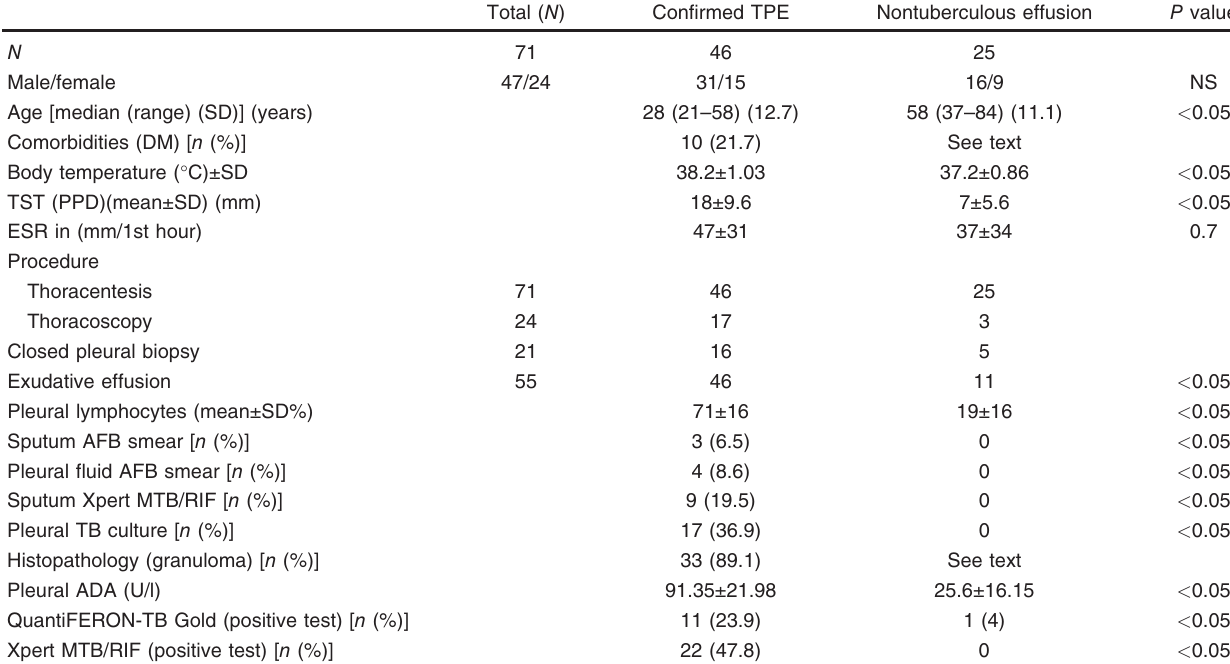
Table 1 The demographic and clinical characteristics of study participants, procedures, and results, categorized as tuberculous ( n = 46) and nontuberculous ( n = 25) pleural effusion groups Total ( N